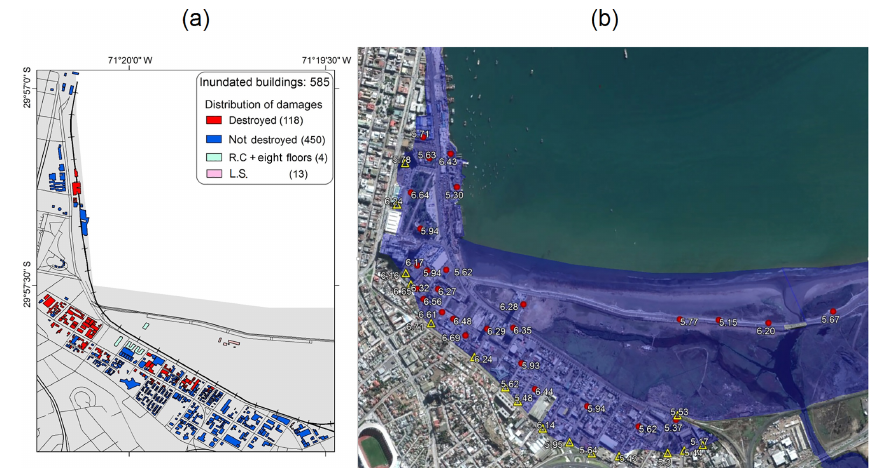
Figure 3. (a) Surveyed damage to structures due to the 2015 tsunami; R.C.: reinforced concrete structures; L.S.: light structures. (b) Co- quimbo inundated area (Aránguiz et al., 2016) and survey data. Red circles represent inundation measures and yellow triangles tsunami